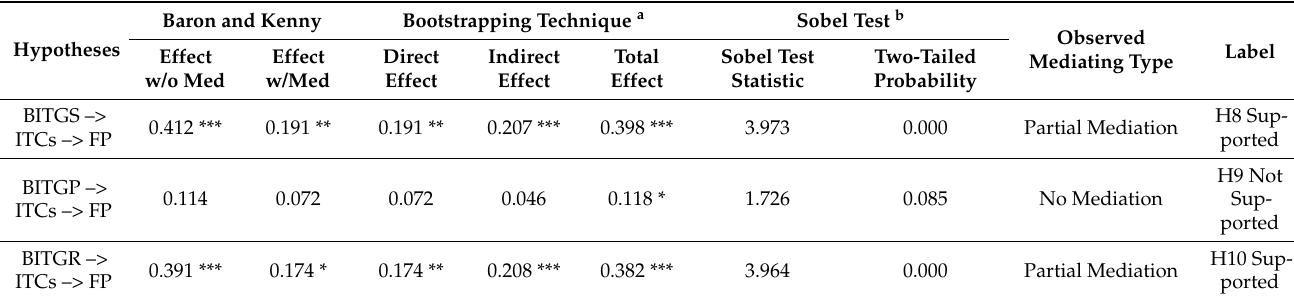
Table 5. Inferring the mediating effect of ITCs on the relationship between BITG characteristics and